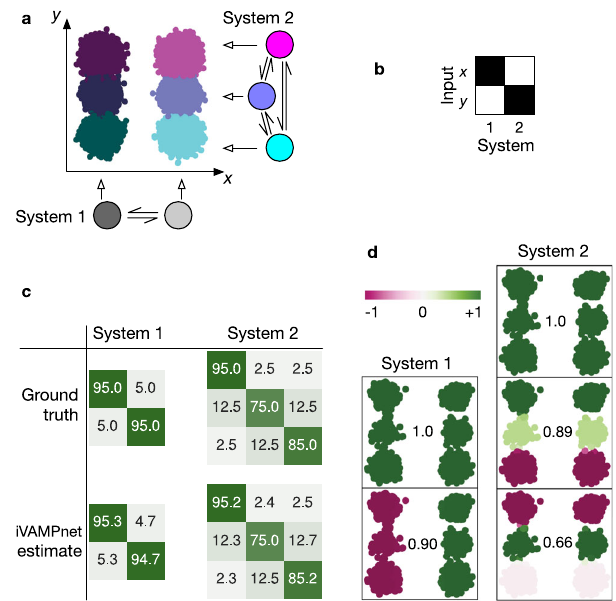
Fig. 3 | Hidden Markov state model as a benchmark example for independent subsystems. a 2 subsystems with 2 and 3 states emit independently to an x and y axis, respectively. The corresponding 2D space embeds all 6 global states. b The learned mask, depicted in gray-scale from 0 (white) to 1 (black), shows that each subsystem focuses on one input dimension. c The estimated subsystem transition matrices are compared with the ground truth (in percent). d Subsystem eigen- functions (color-coded) and corresponding eigenvalues (number prints) as found by iVAMPnet. Independent processes are recovered from the 2D